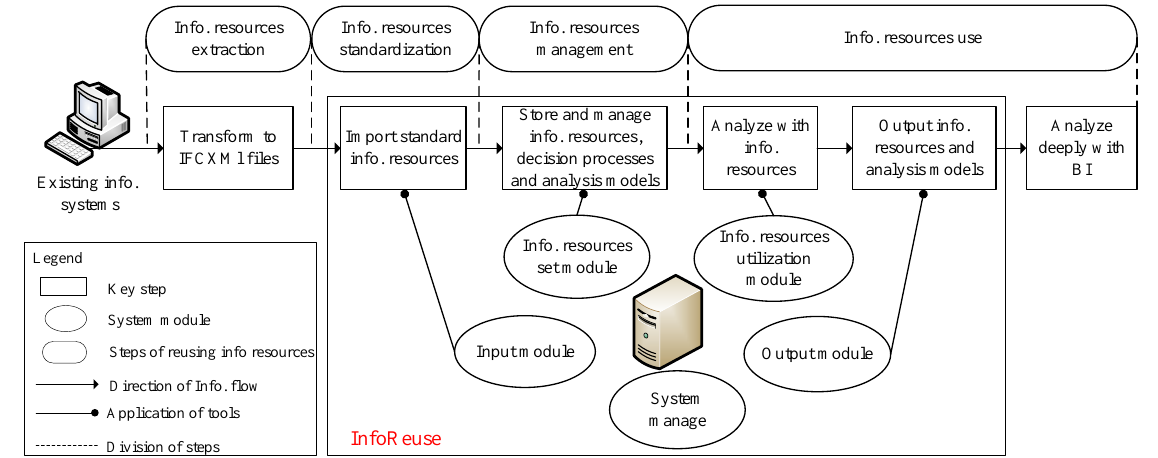
Figure 7 System model of InfoReuse (Lu